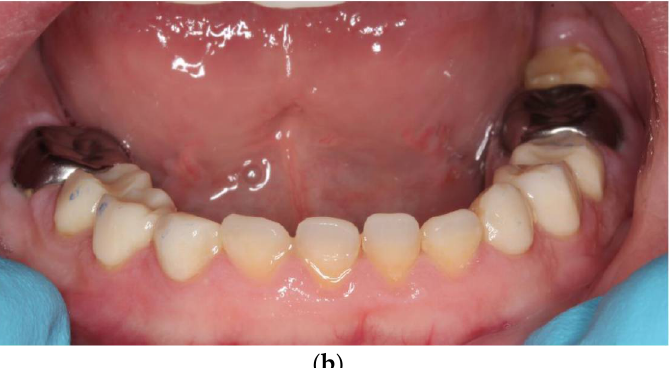
Figure 8. A 12-year-old patient with AI type II: ( a ) upper teeth; ( b ) lower teeth. Oral surgery was performed under general anesthesia using indirect composite restorations and stainless steel crowns.